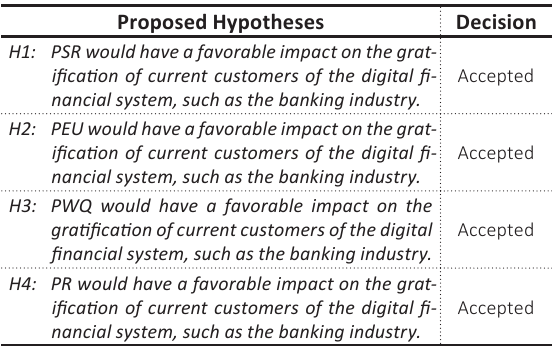
Table 3. Hypothesis testing summary